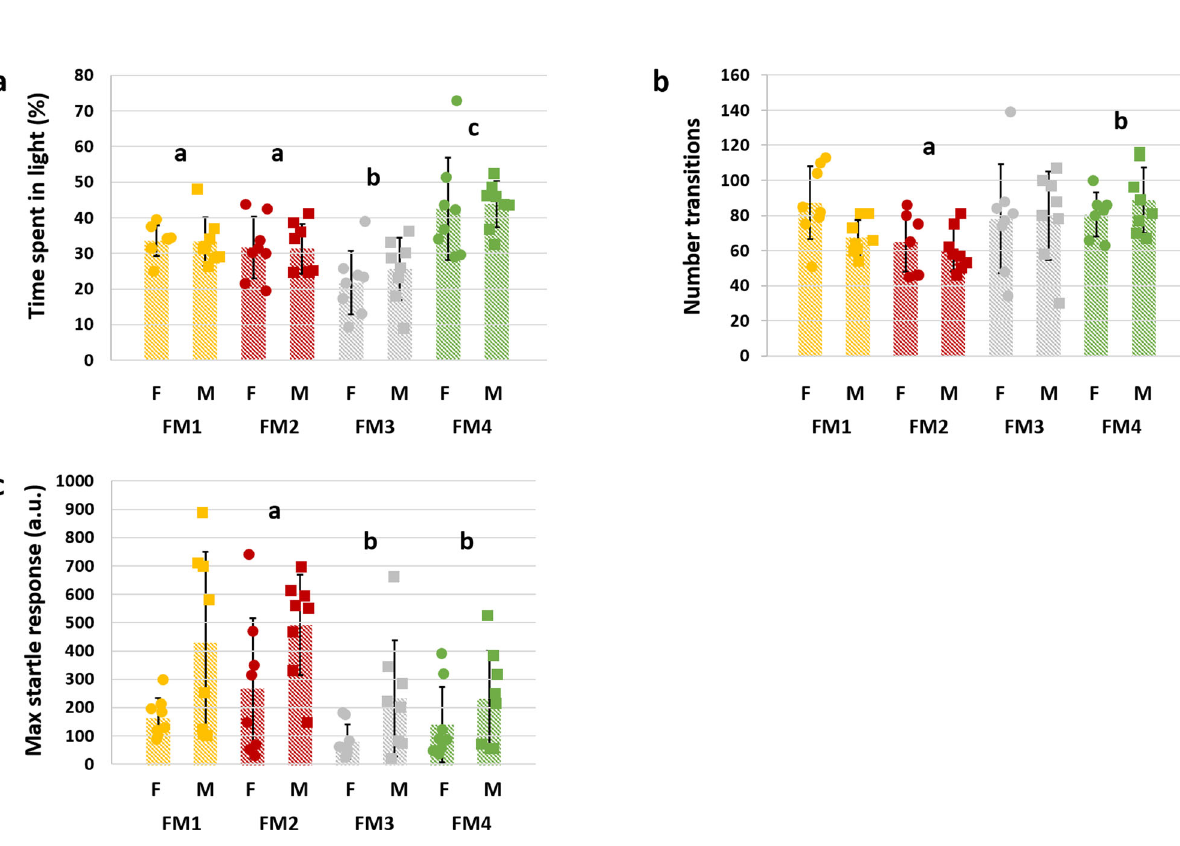
Fig. 3 Supplier-dependent FMs are associated with different anxiety-related behavior. a Dot plot showing the percent time spent in the illuminated half of a light/dark chamber by female (F) and male (M) mice colonized with FM1, FM2, FM3, or FM4 ( p < 0.001, F = 13.7). b Dot plot showing the total number of transitions between the two halves of a light/dark chamber by female and male mice colonized with FM1, FM2, FM3, or FM4 ( p = 0.02, F = 3.6). c Dot plot showing the response to startle in arbitrary units (a.u.) by female and male mice colonized with FM1, FM2, FM3, or FM4 ( p = 0.006, F = 4.6). p and F values represent main effects of FM in two-way ANOVA, and post hoc comparisons via Holm – Sidak method; signi fi cant pairwise FM- dependent differences are denoted by different letters, n = 8/sex/FM at all time-points, underlying bar charts represent mean ±